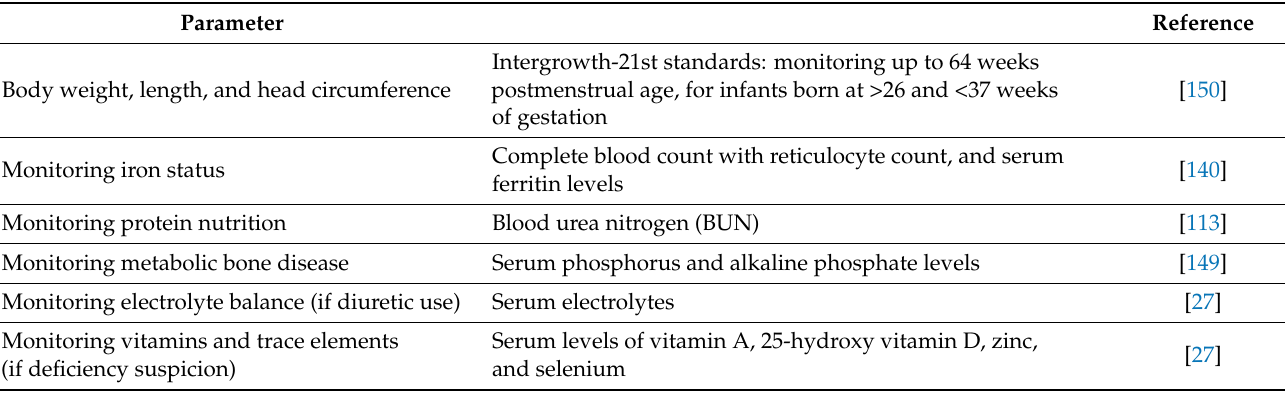
Table 4. Monitoring infants with BPD after